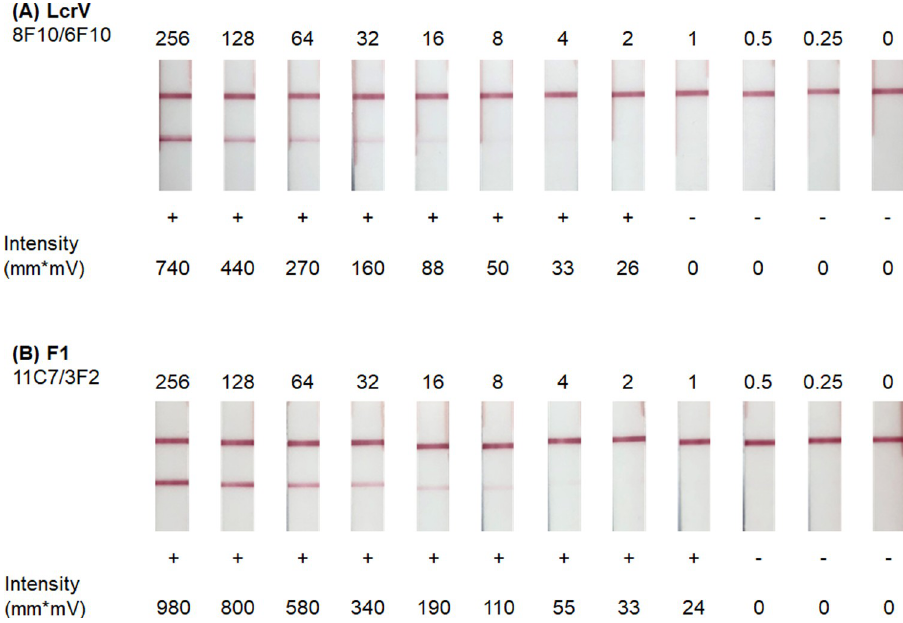
Fig 3. Sensitivity of Y . pestis lateral flow immunoassays (LFI) using recombinant LcrV and F1. LFI prototypes were tested with recombinant (A) LcrV and (B) F1 serial diluted into pooled normal human serum ranging from 0.25 to 256 ng/mL. Assay signal was evaluated and quantitated by optical density using a Qiagen ESE reader. Intensity � 20 mm � mV scores as positive.